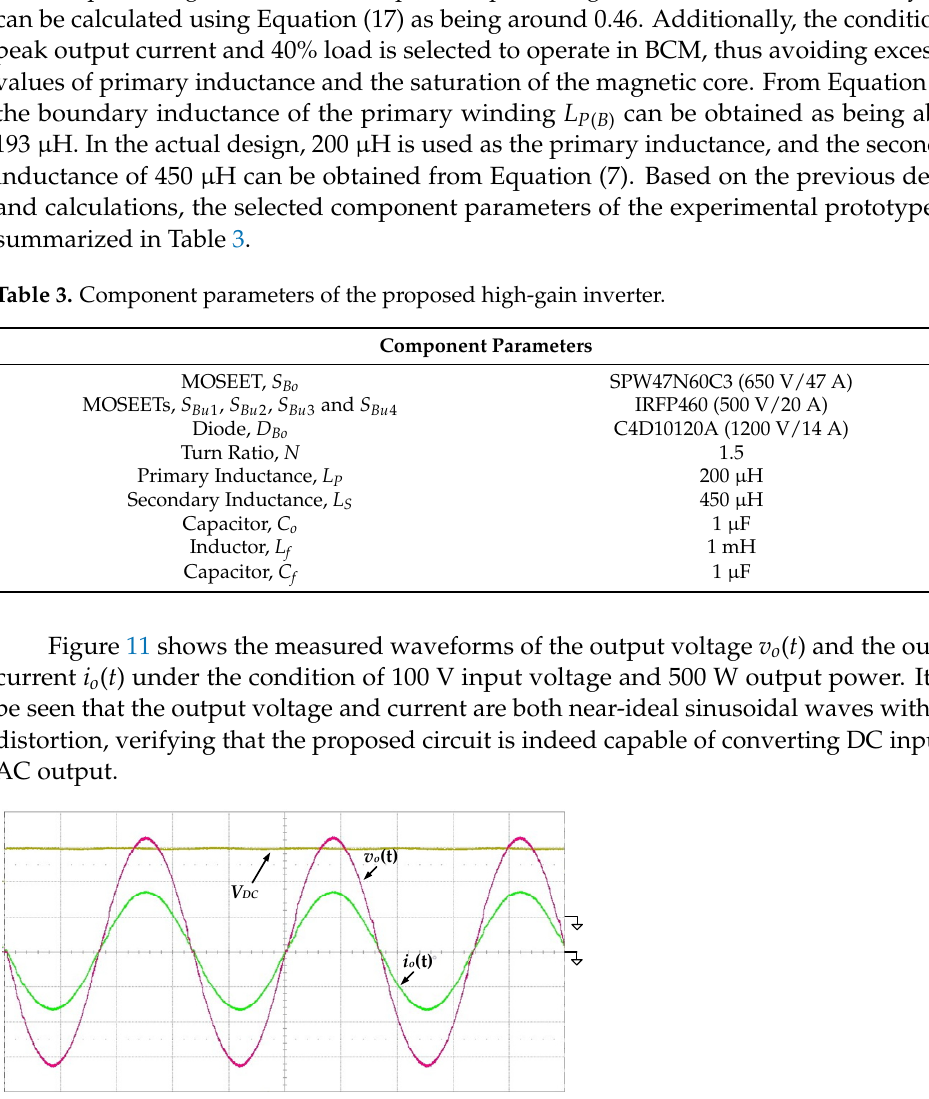
Table 3. Component parameters of the proposed high-gain inverter.